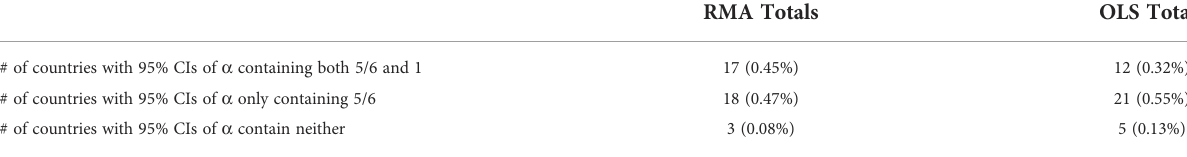
TABLE 1 The number and percentage of countries in 2015 with scaling exponents from containing isometry ( a = 1) and/or the UST predicted values ( a = 5/6) based on 95% Con fi dence Intervals.